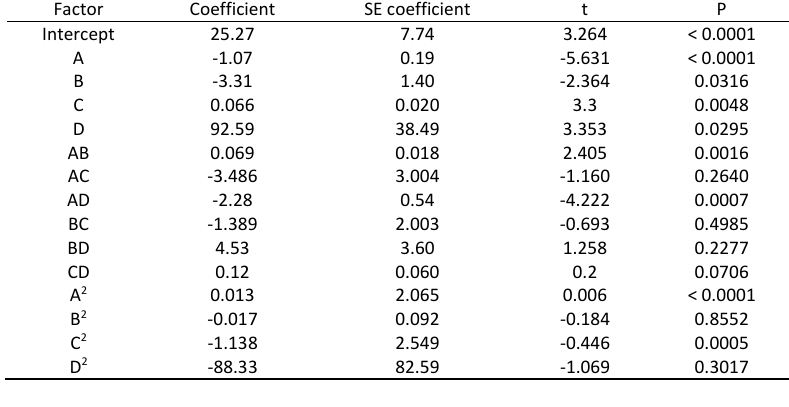
process of AO10 removal 4